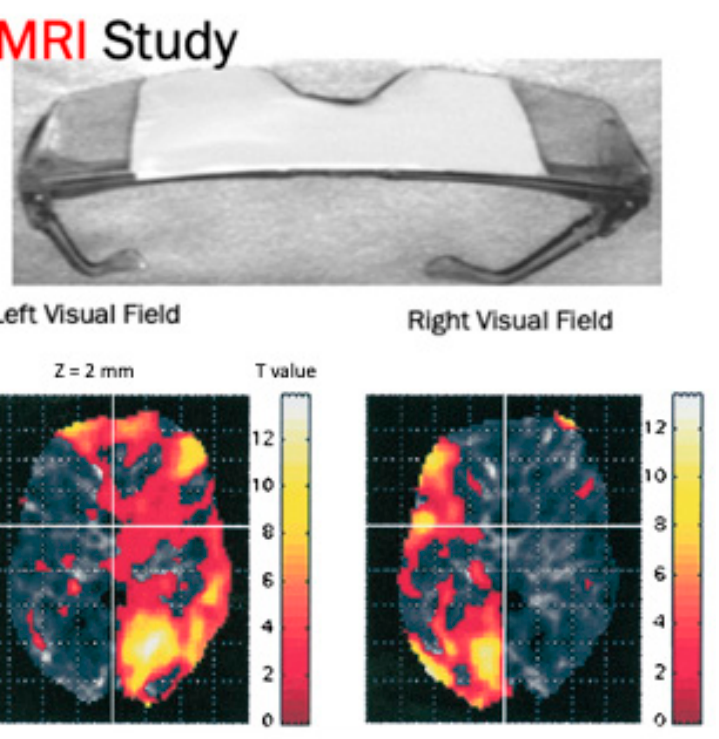
Figure 1. This image shows the mean fMRI results of 7 healthy subjects as they look out of each lateral visual field. Looking out of each visual field activated relatively the contralateral hemisphere [17].